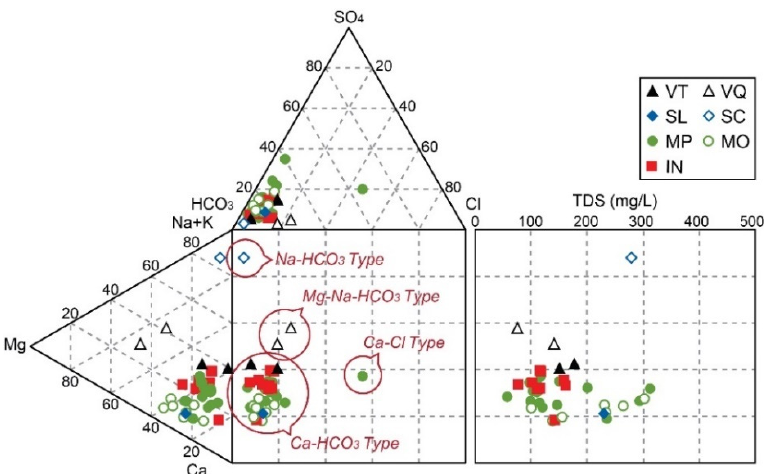
Figure 2. Durov diagram showing the hydrochemical types of South Korean bottled water samples ( n = 37) classified, which were clustered into 7 groups according to geological units around boreholes. Four samples with hydrochemical types other than the Ca-HCO 3 type were classified as outliers (see Supplementary Table S4). The geological units of the index are as follows (see also Table 1): VT and VQ = volcanic rocks; SL and SC = sedimentary rocks; MP and MO = metamorphic rocks; IN = intrusive rocks (see also Table 1).